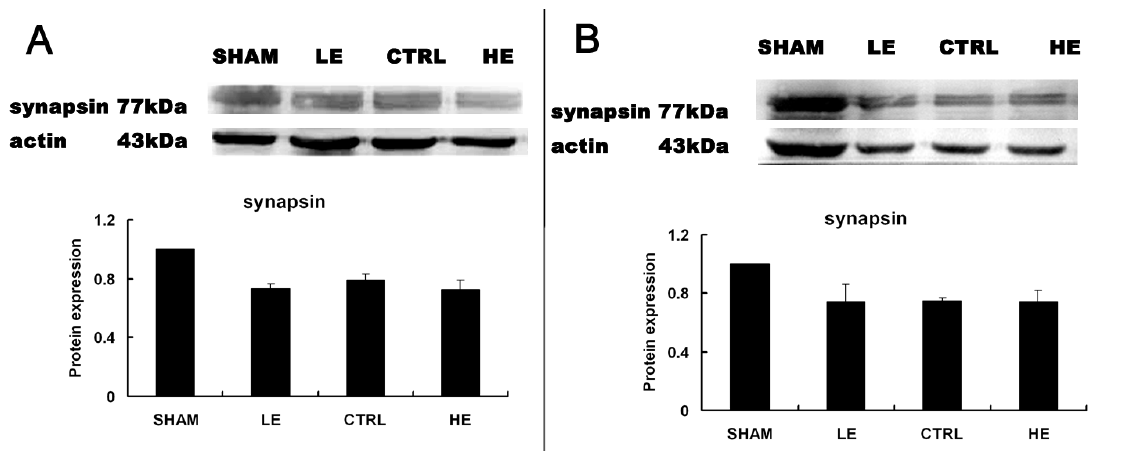
Figure 5. Effects of treadmill exercise on hippocampal synapsin I. ( A )The levels of synapsin I were similar in the LE and HE group compared to the CTRL group in the contralateral hippocampus( p > 0.05); ( B ) The levels of synapsin I were similar in the LE, CTRL and HE group in the ipsilateral hippocampus ( p > 0.05). The data are represented as the means ±